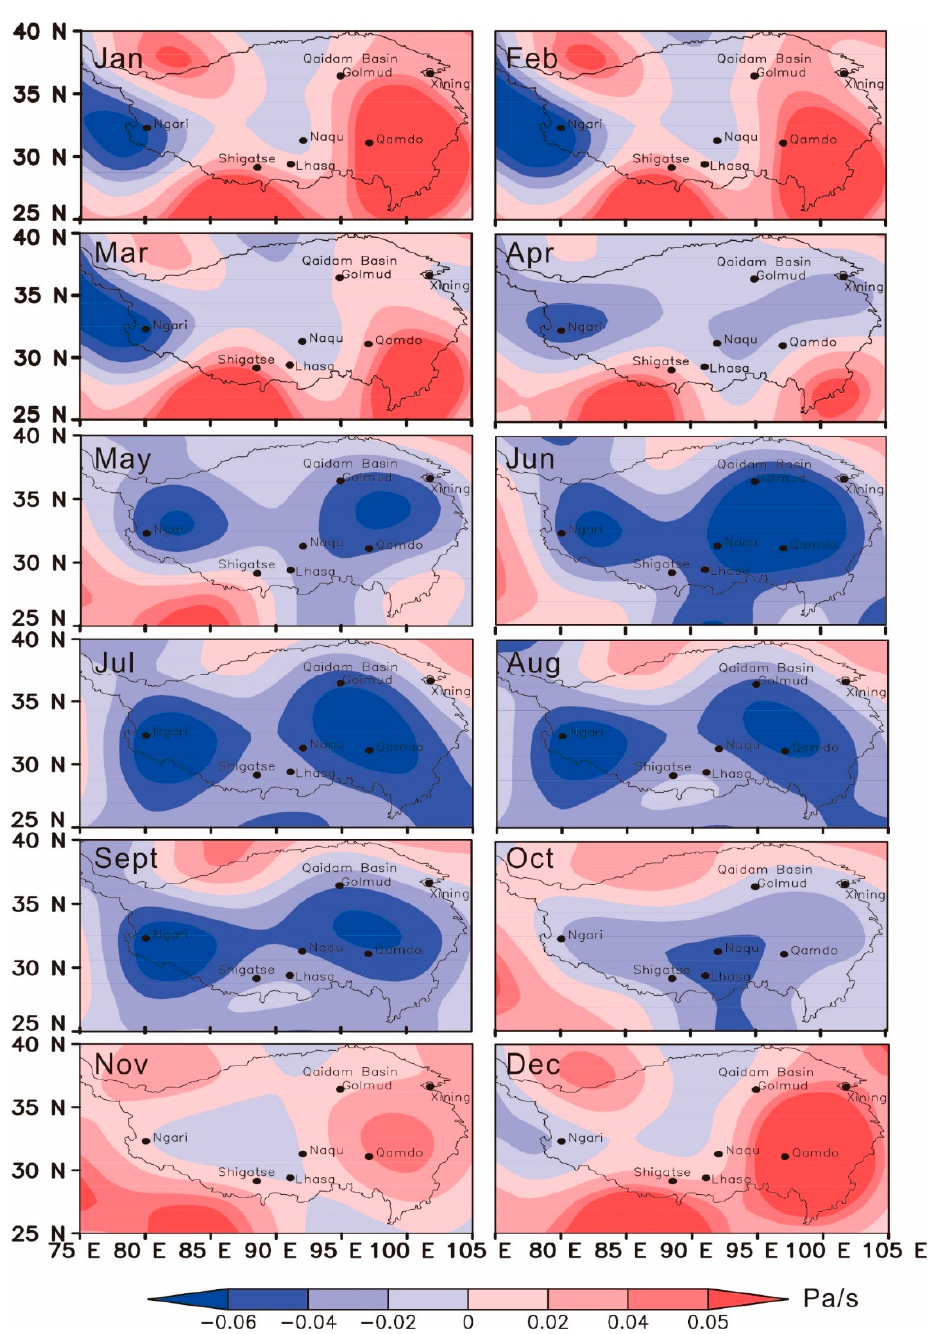
Figure 2. Monthly means of vertical velocity over the Tibetan Plateau at 500 hPa from 1981 to 2010.